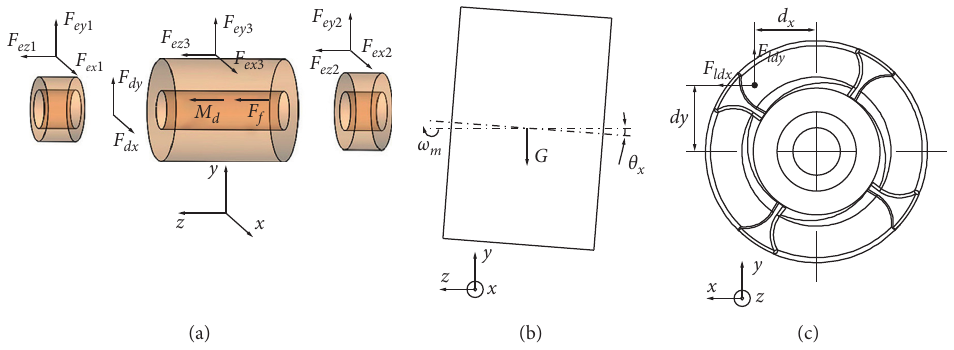
Figure 14: Schematics of the different forces acting on the rotor and corresponding coordinate systems.